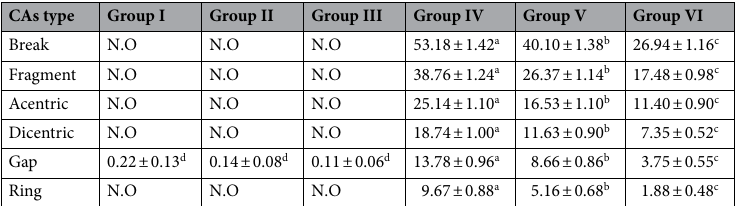
Table 4. CAs frequency in AFB 2 and resveratrol treated groups. Values are shown as mean ± SEM (n = 6). Data shown with different letters (a–d) in the same line are statistically significant (p < 0.05). Group I: control, Group II: 10 mg/kg b.w resveratrol, Group III: 20 mg/kg b.w resveratrol, Group IV: 20 µg/kg b.w AFB 2 , Group V: 10 mg/kg b.w resveratrol + 20 µg/kg b.w AFB 2 , Group VI: 20 mg/kg b.w resveratrol + 20 µg/kg b.w AFB 2 . N.O not